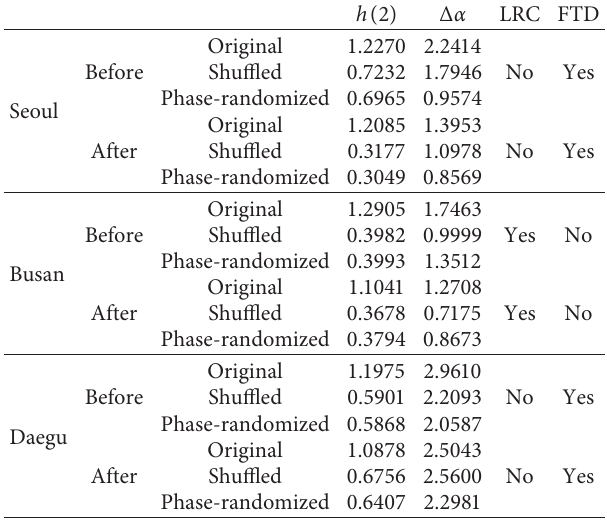
Table 5: Multifractality of PM